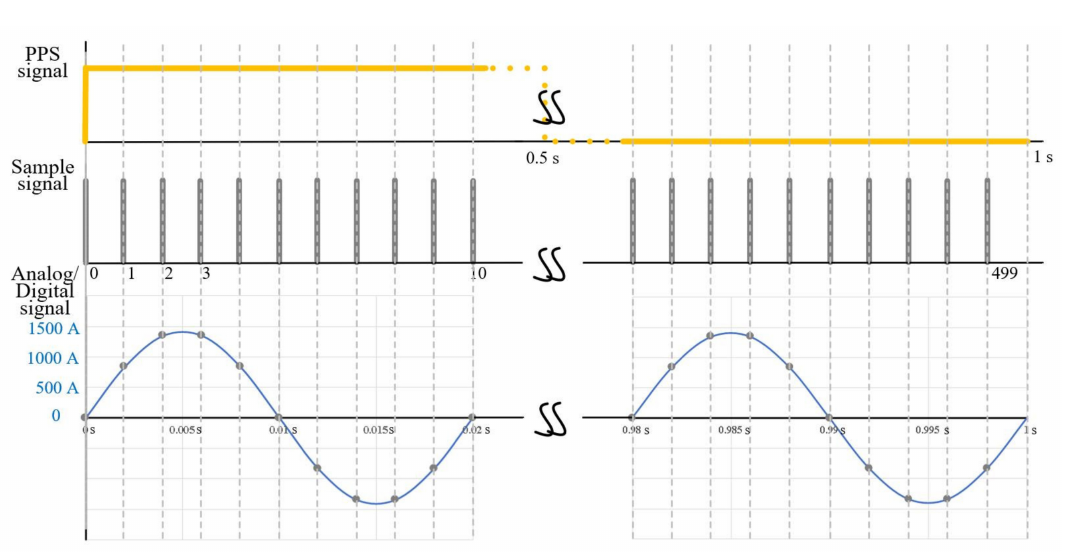
Figure 1. Principle scheme of the sampling process for the SV-based devices according to standard IEC 61869-9. For illustration purpose, a non-standardized sample rate of 500 S / s (10 samples per period at 50 Hz) is applied.